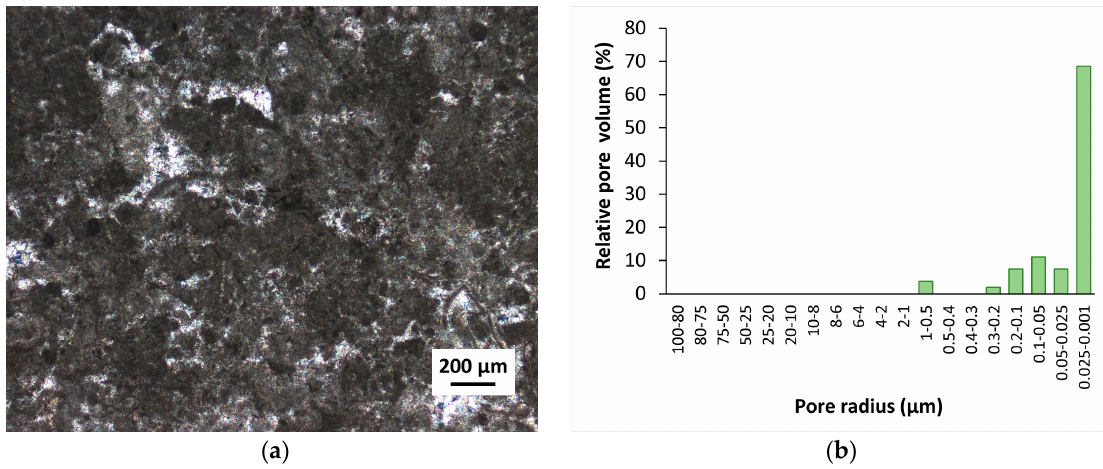
Figure 2. Trani stone: ( a ) image taken on thin sections through optical microscope (Eclipse LV 100 PL, Nikon, Tokyo, Japan) in transmitted light; ( b ) pore-size distribution curve.